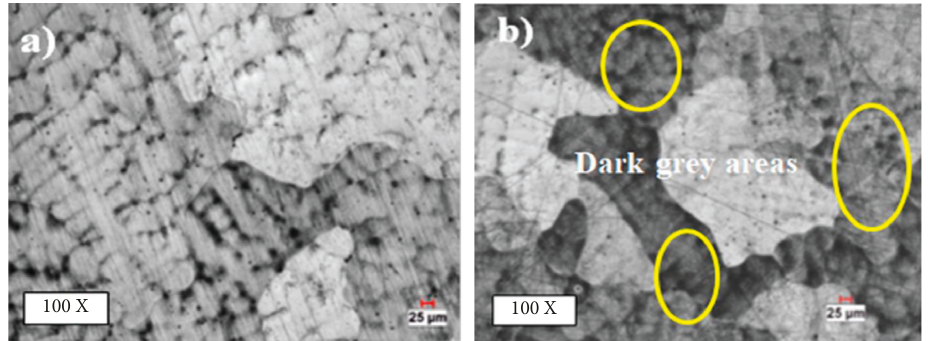
Figure 5: Microstructure images for (a) unreinforced Ni-alloy and (b) Ni-alloy/TiO